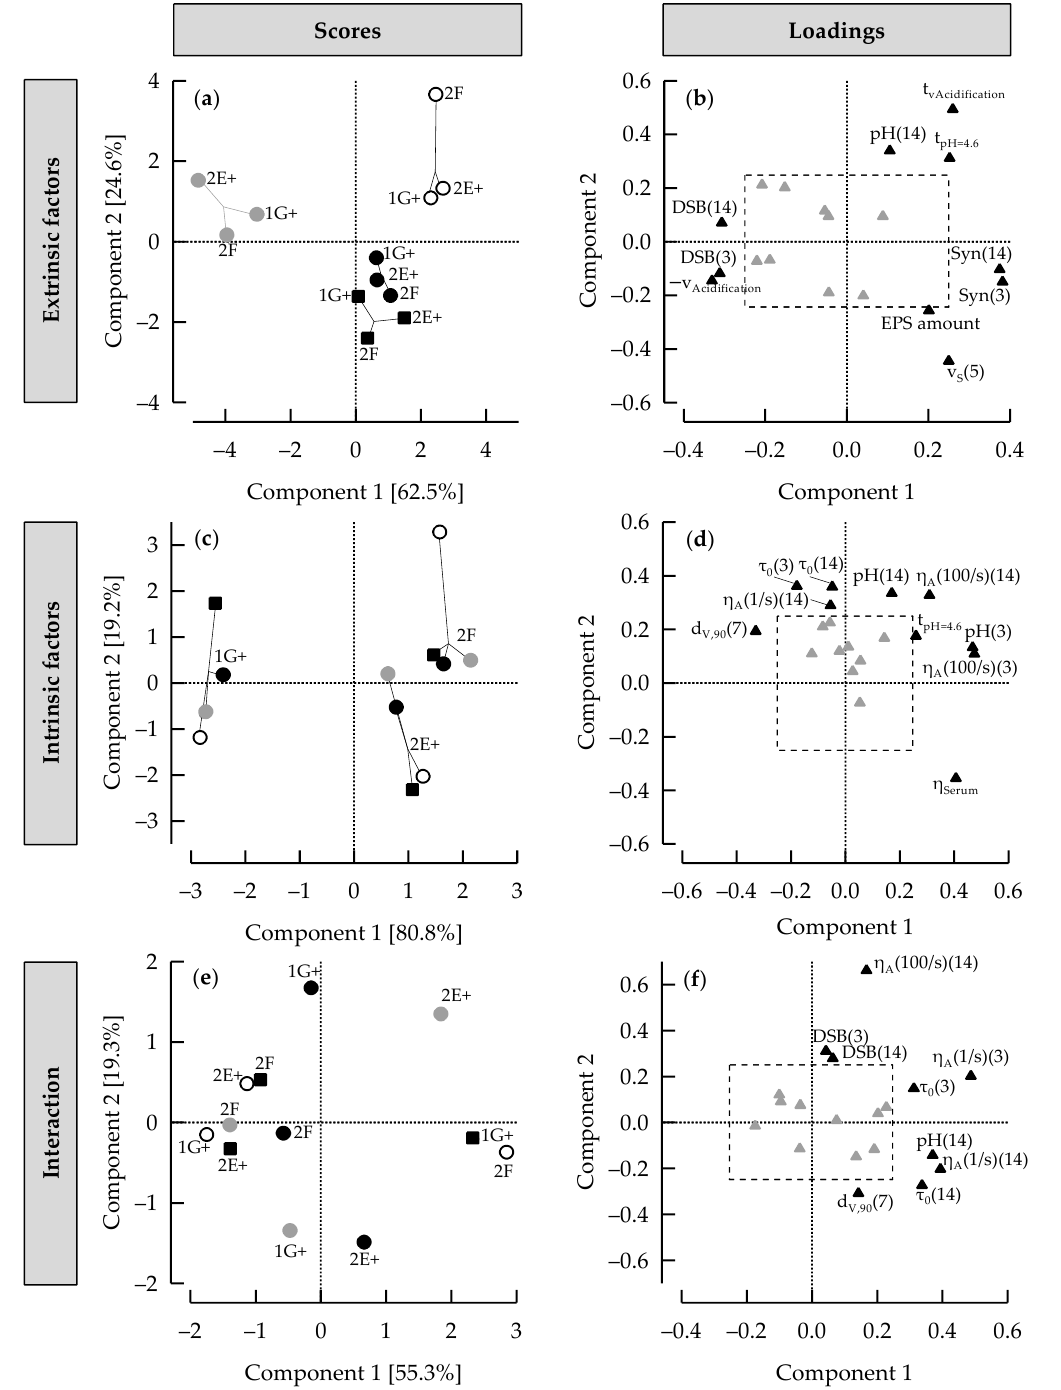
Figure 7. Averaged scores (dimensionless) of the ( a ) extrinsic and ( c ) intrinsic factors as well as their ( e ) interaction of ASCA+ analysis (for explanation of circles and squares see caption of Figure 1). Variance of component is indicated as percentage in square brackets. Loadings ( b , d , f ); dimensionless) that were ≥ |0.25| (indicated by dashed line) in one component are labeled with: Syn, forced syneresis; DSB, degree of structural breakdown and see text as well as figure captions (black trian- gles). The information in round brackets indicates the cold storage period in days. All other loadings are displayed as grey triangles. Please note different x- and y-axis scaling in charts.